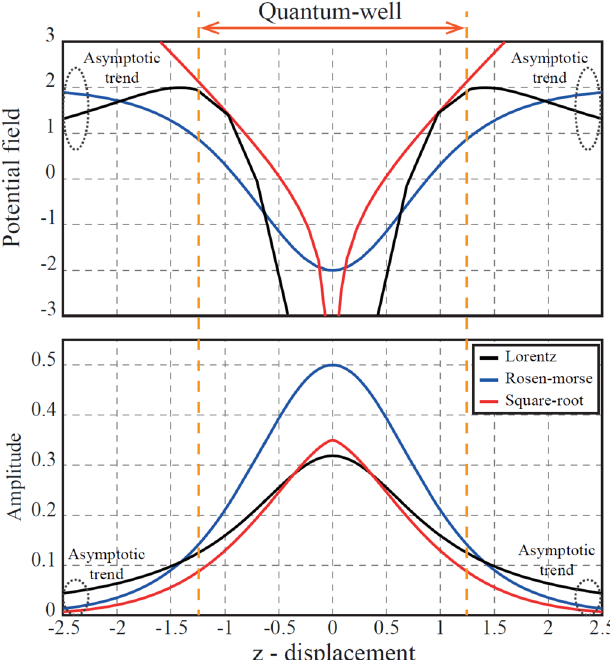
Figure 2. Probability density functions associated with the potential